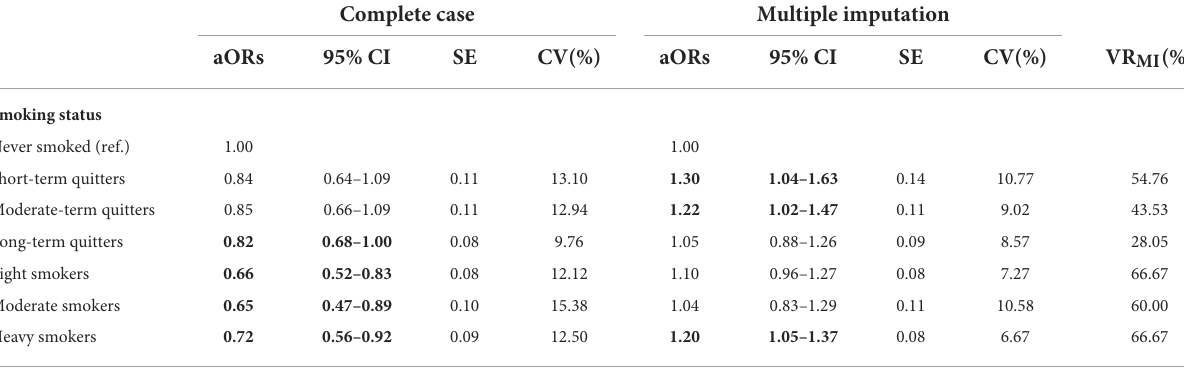
TABLE 5 Fixed effects logistic regression analysis for the complete case and multiple imputation.